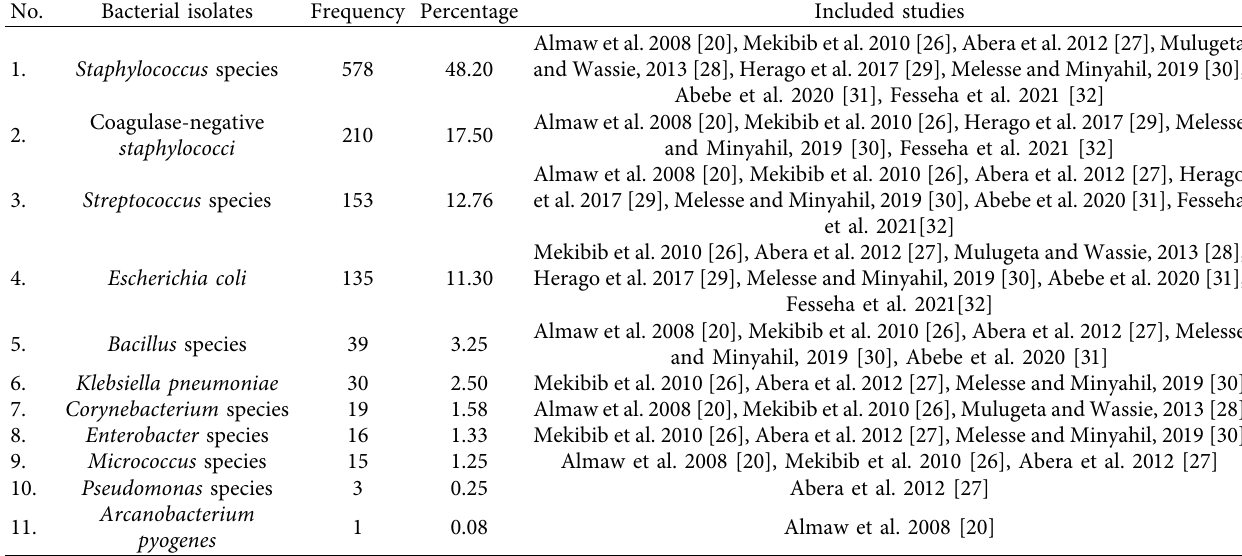
Table 1: Total frequency and percentage of bacterial infections isolated from eight selected studies that cause bovine